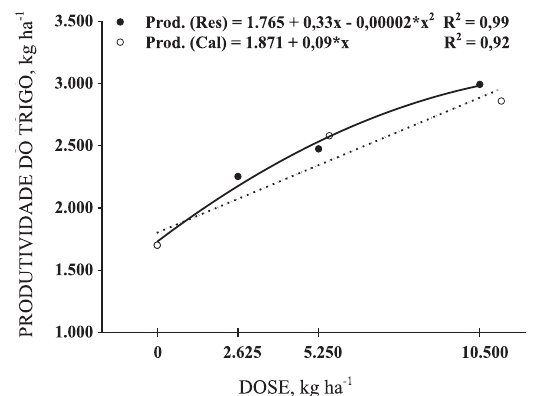
Figura 5. Produtividade da cultura do trigo em um solo corrigido com doses crescentes de resíduo alcalino (Res) e calcário (Cal), aplicadas em superfície, calculadas com base no método SMP, Lages – SC. (*: significativo a 5